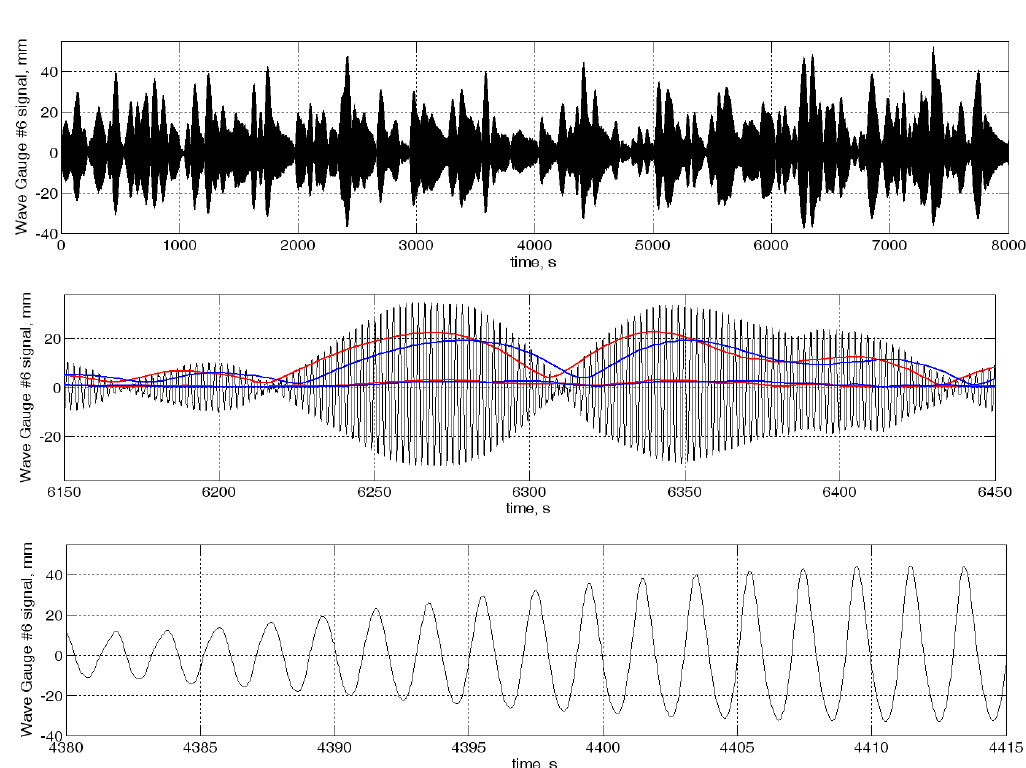
Fig. 3. Top: a typical wave gauge signal; Middle: zoomed signal with reconstructed amplitudes of first and second harmonics of the incident (red) and reflected (blue) waves; Bottom: zoomed signal from the wave gauge.